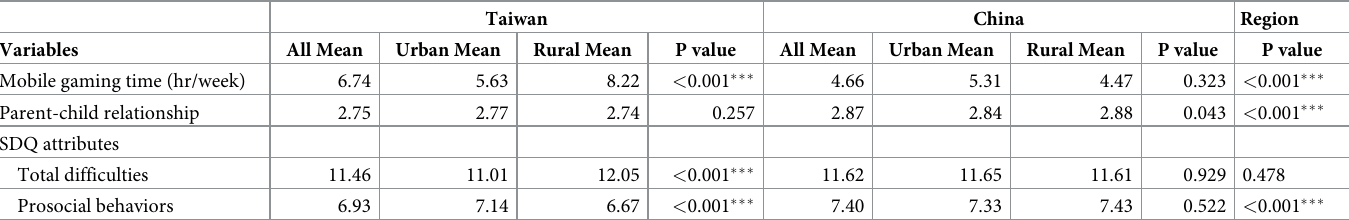
Table 2. Children’s mobile gaming time and SDQ by gaming region and urban/rural